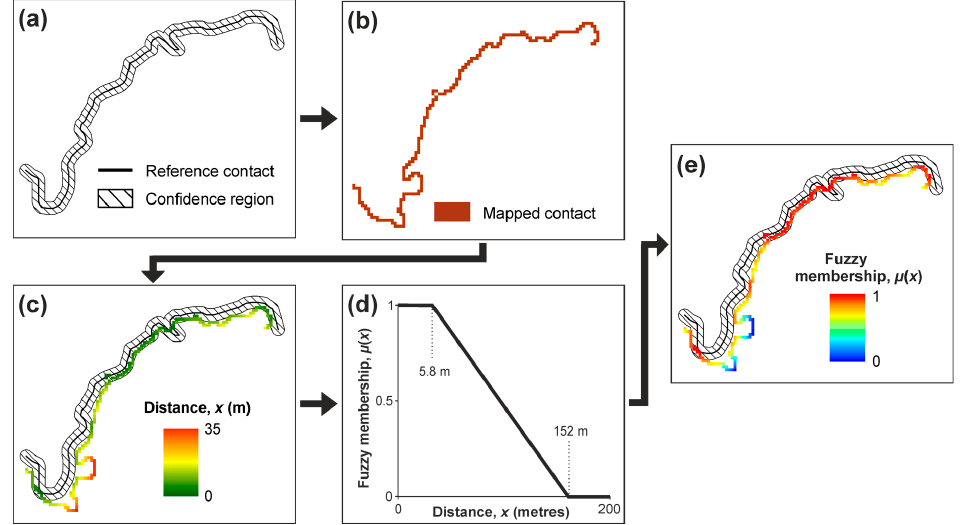
Figure 4. Assessing the accuracy of delineated contacts: ( a ) positional confidence region defined around reference contact; ( b ) equivalent contact in generated lithological map is identified; ( c ) distances between reference contact and pixels forming delineated contact are computed; ( d ) fuzzy membership function defined; and ( e ) fuzzy membership of contact pixels are computed.